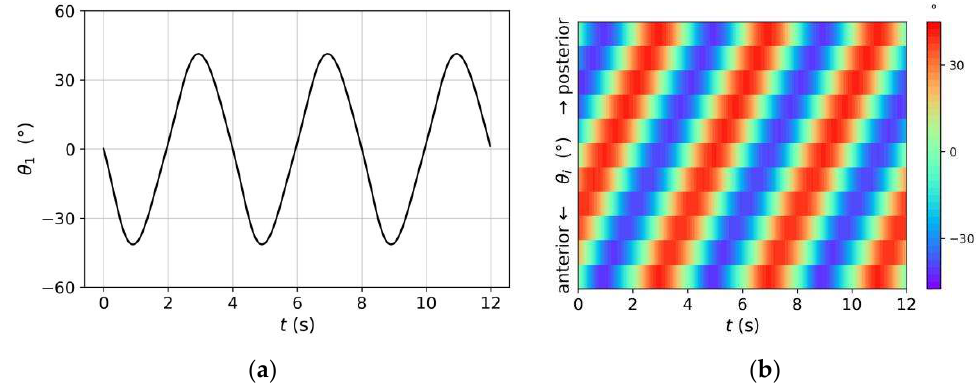
Figure 7. Voltage dynamics of CPG neurons.